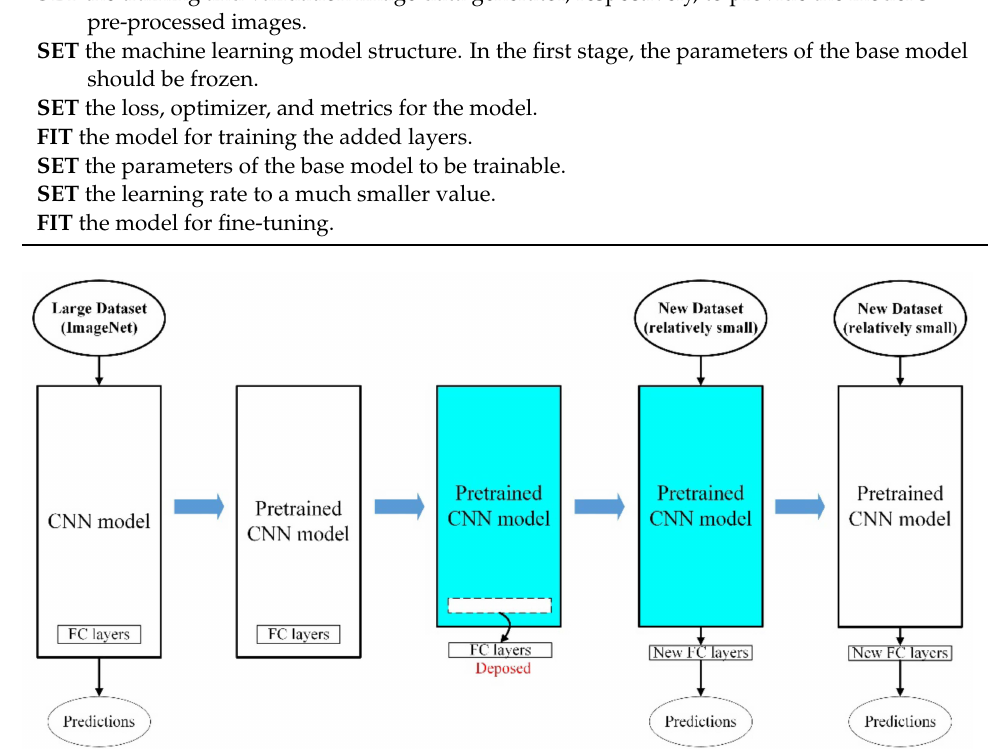
Figure 11. The diagram of the transfer learning